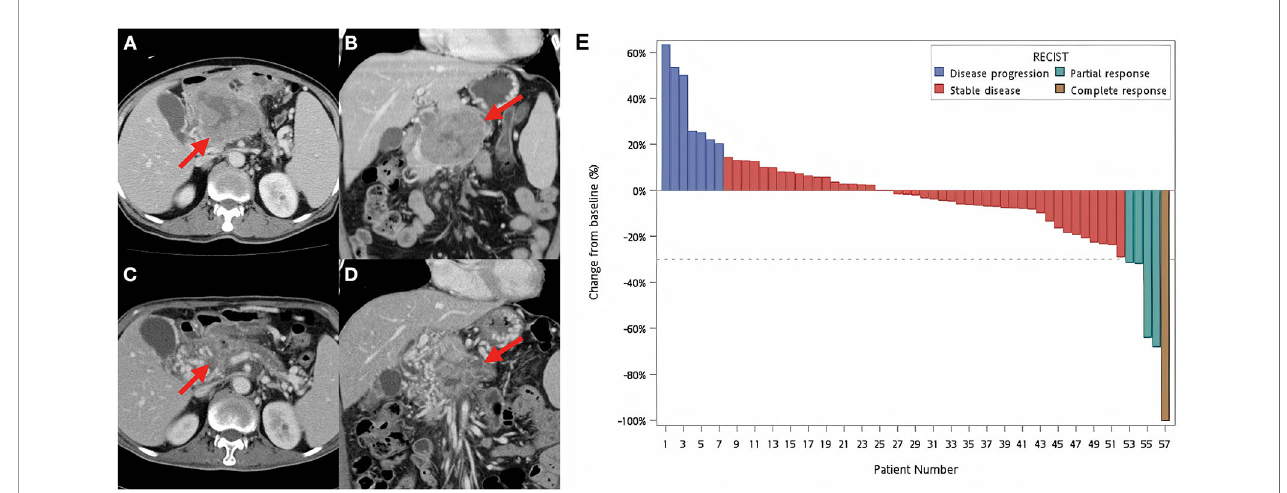
FIGURE 1 | Example of a responsive tumor and waterfall plot for all patients. Contrast-enhanced CT images before (A, B) and after (C, D) de fi nitive concurrent chemoradiotherapy. (A, B) A huge necrotic pancreatic tumor around 10 cm was found (red arrows). The patient was treated by concurrent fl uorouracil, erlotinib with 55 Gy in 25 fractions to the pancreatic tumor, and 45 Gy in 25 fractions to the adjacent lymphatics. (C, D) Follow-up CT images were obtained 1 month after the completion of de fi nitive chemoradiotherapy. The red arrows identi fi ed the radiotherapy-treated tumor with signi fi cant volume reduction. (E) Waterfall plot of each patient at the best radiographic response according to Response Evaluation Criteria in Solid Tumors (RECIST) guidelines (version